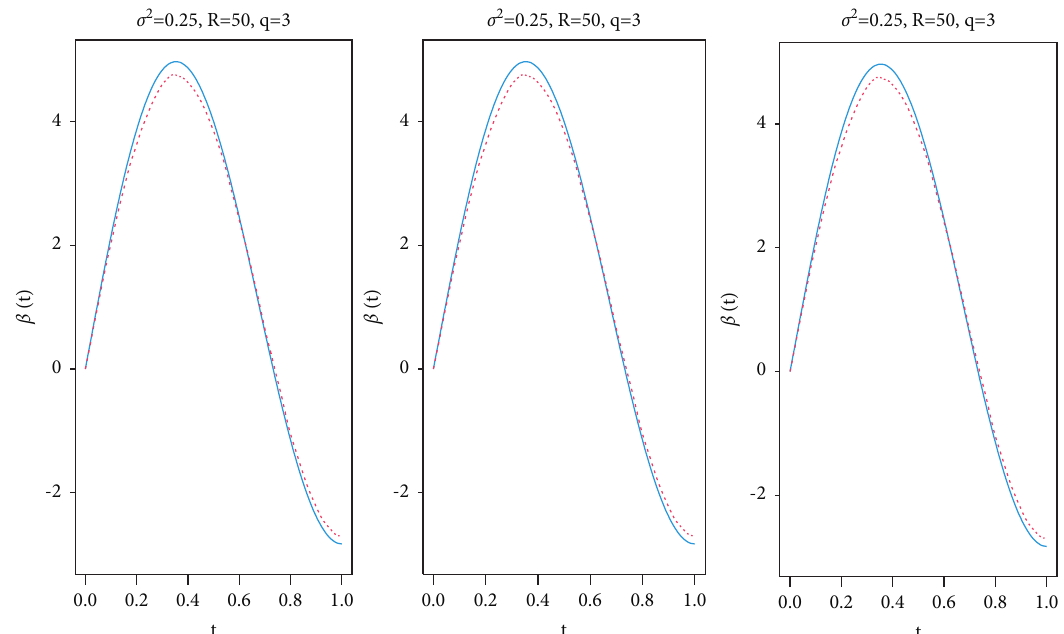
Figure 1: The estimated functional coefficient versus true value of β ( t ) with different ρ s (from left to right responding to ρ � 0 . 5 , 0 , − 0 . 5) when R � 50 ,q � 3 , and σ 2 � 0 . 25.